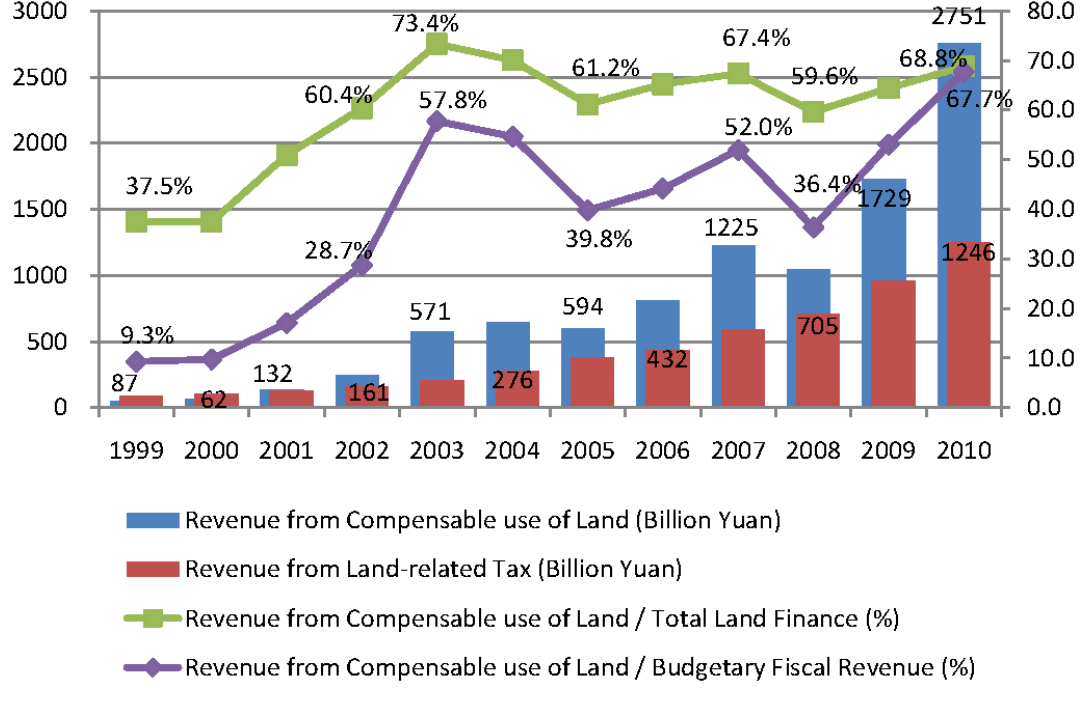
Figure 3. The structure of land finance and its size relative to budgetary fiscal